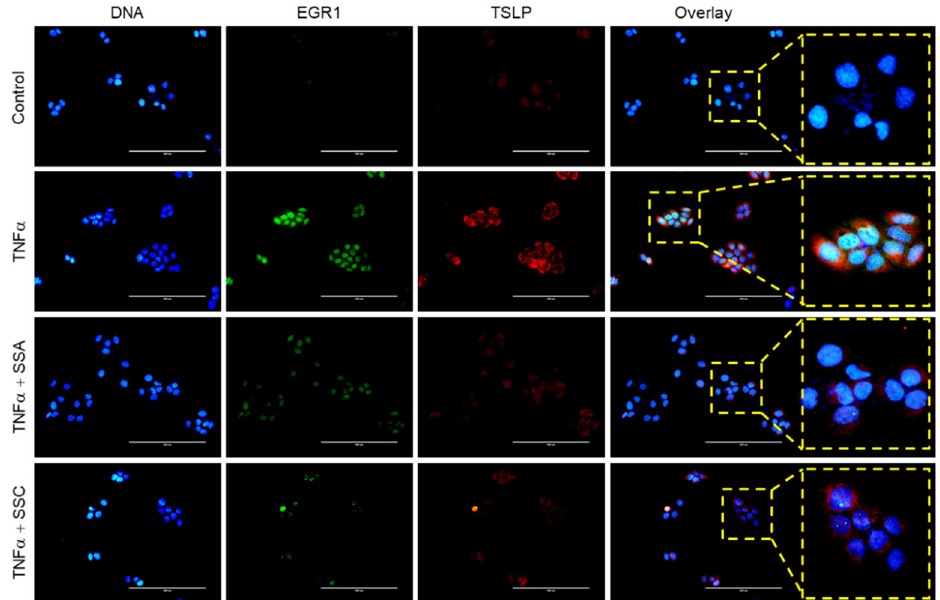
Figure 6. Subcellular localization of TNF- α -induced EGR1 and TSLP proteins. HaCaT cells were treated with 10 ng/mL of TNF- α for 12 h in the absence or presence of 1 µM SSA or 20 µM SSC. Immunofluorescence staining determined the localization of EGR1 (green) and TSLP (red). Nuclei were counterstained using 1 µg/mL Hoechst 33258 (blue). Scale bars, 200 µm.